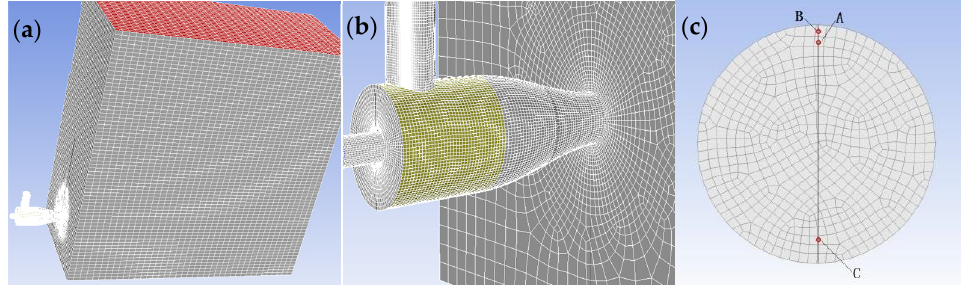
Figure 2. Meshing diagram of nozzle and observation tank. ( a ) Combined meshing diagram of observation tank and annular jet nozzle. ( b ) Meshing diagram of annular jet nozzle. ( c ) Cross– section mesh of the annular nozzle on X = 0.065 m.